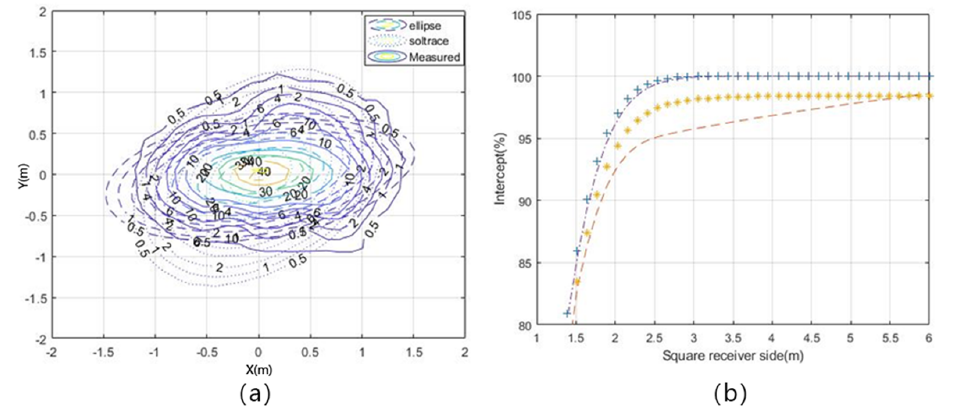
Figure 16. ( a ) Contours of the measured and computed flux distribution (kW/m 2 ): Heliostat #10, ( b ) measured and computed intercepts vs. the side length of a square receiver: Heliostat #10 . Table 4. The absolute average difference in flux density of ten heliostats.